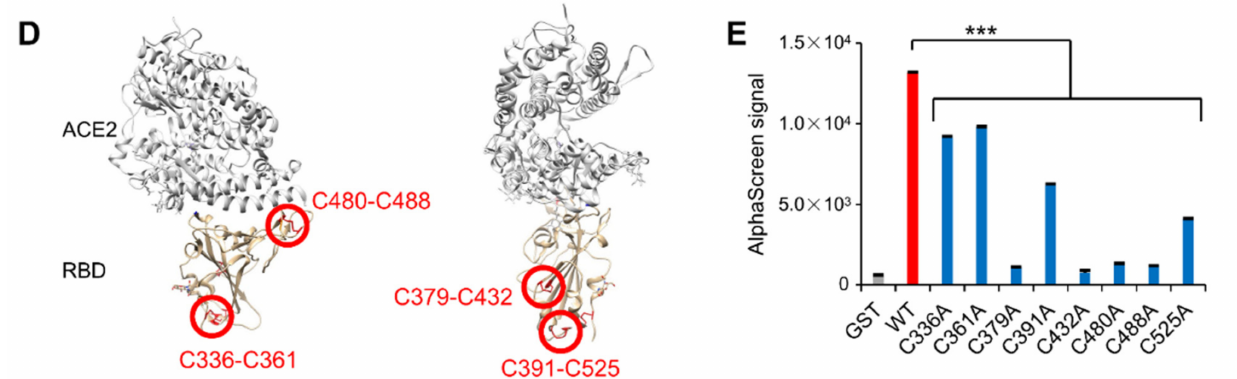
Figure 3. Development of AlphaScreen assay to evaluate the RBD–ACE2 interaction. ( A ) Schematic representation of AlphaScreen assay to measure the binding between biotinylated RBD and flag- tagged ACE2 produced by wheat germ cell-free protein synthesis system with ERO1 α and PDI (EP- WG). ( B ) Comparison of AlphaScreen signal of each protein synthesized by two different methods. Biotinylated GST and flag-tagged DHFR were used as negative controls. AlphaScreen signal was normalized by relative protein amounts. ( C ) Disulfide-bond-containing RBD protein was incubated with or without 100 mM of DTT for 30 min at 37 ◦ C prior to AlphaScreen assay. ( D ) Localization of disulfide bonds in the RBD protein in the tertiary structure of the RBD bound to ACE2. Disulfide bonds in the SARS-CoV-2 RBD are shown as sticks and indicated by red circles. The protein structure was obtained from PDB ID 6m0j. ( E ) Mutation analysis of cysteine residues of RBD for ACE2 interaction. AlphaScreen assay was carried out using RBD possessing alanine substitution in each cysteine residue. AlphaScreen signal was normalized by relative protein amounts. WT, Wild Type. All graph data are presented as mean ± SD, Welch‘s t test (two-tailed), ** p < 0.01, *** p <